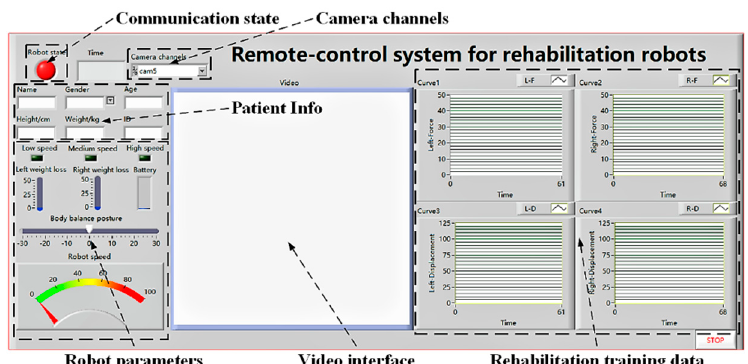
Figure 9. Remote control system interface for rehabilitation robot.